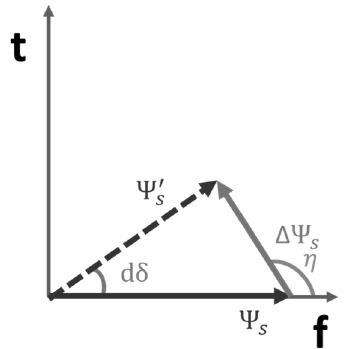
Figure 2. The flux linkage vector in the f - t frame.